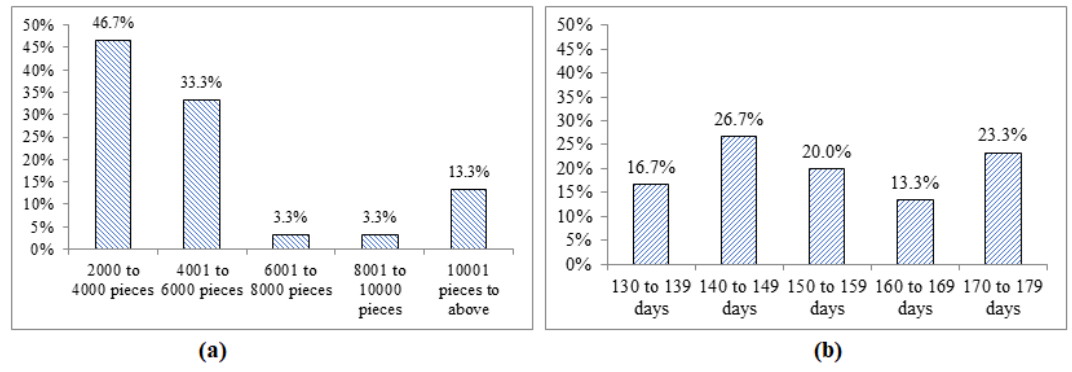
Figure 4. Variation on contracts depending on (a) quantity and (b) lead time